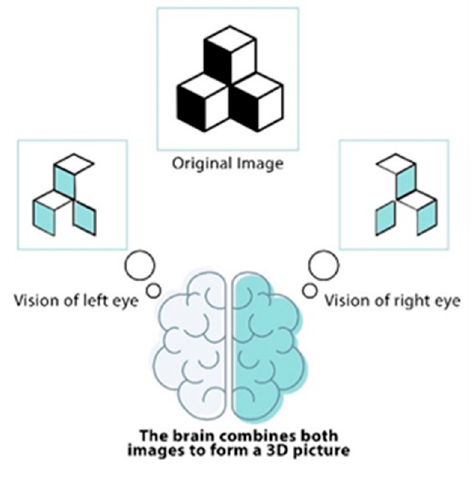
Figure 4. How our brains process images.